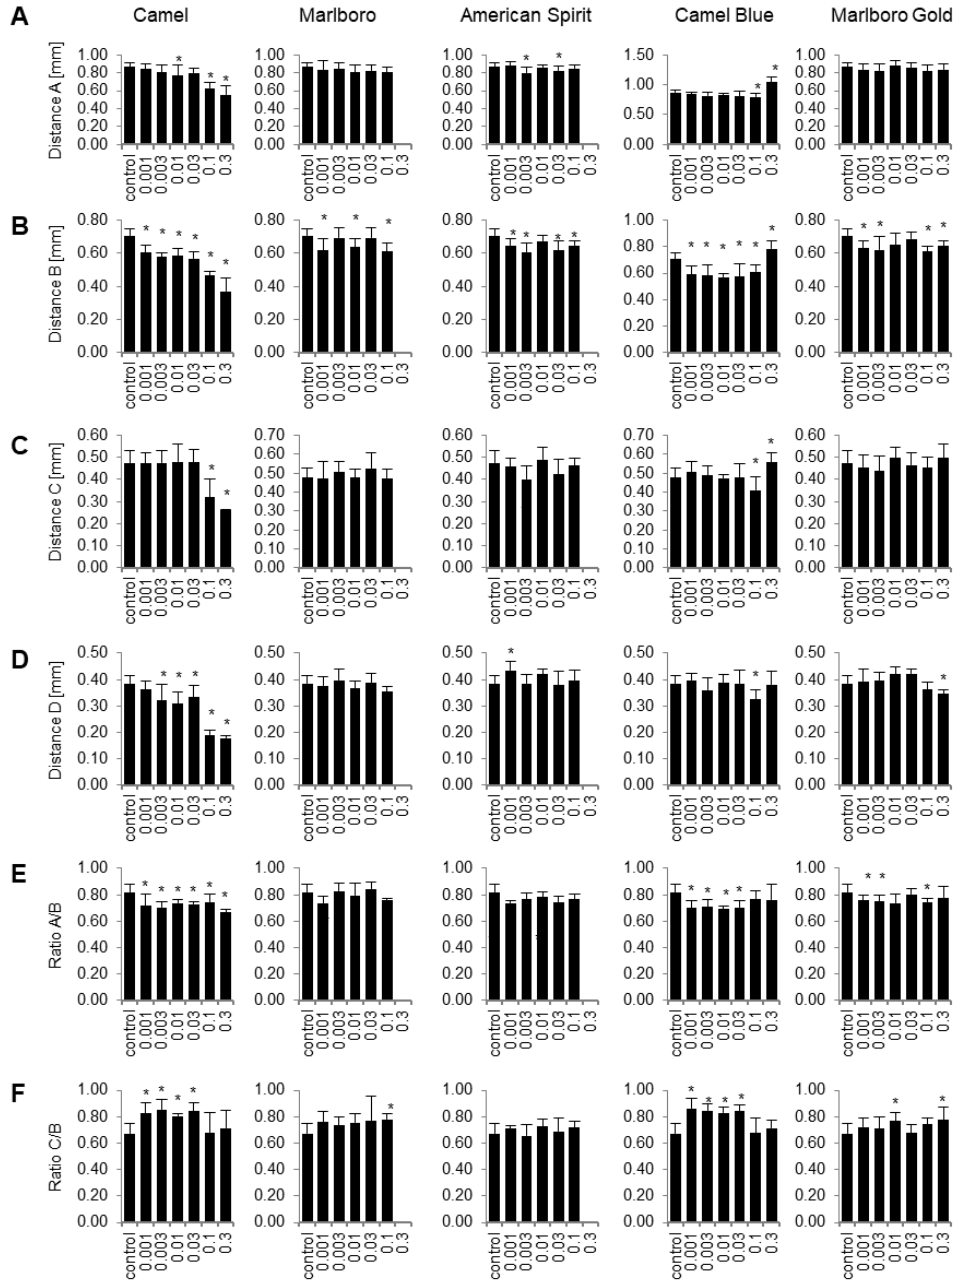
Distance C: from the right hyosymplectic to the top of ceratohyal. Distance D: from the right articulation to the left articulation (compare Figure 4).